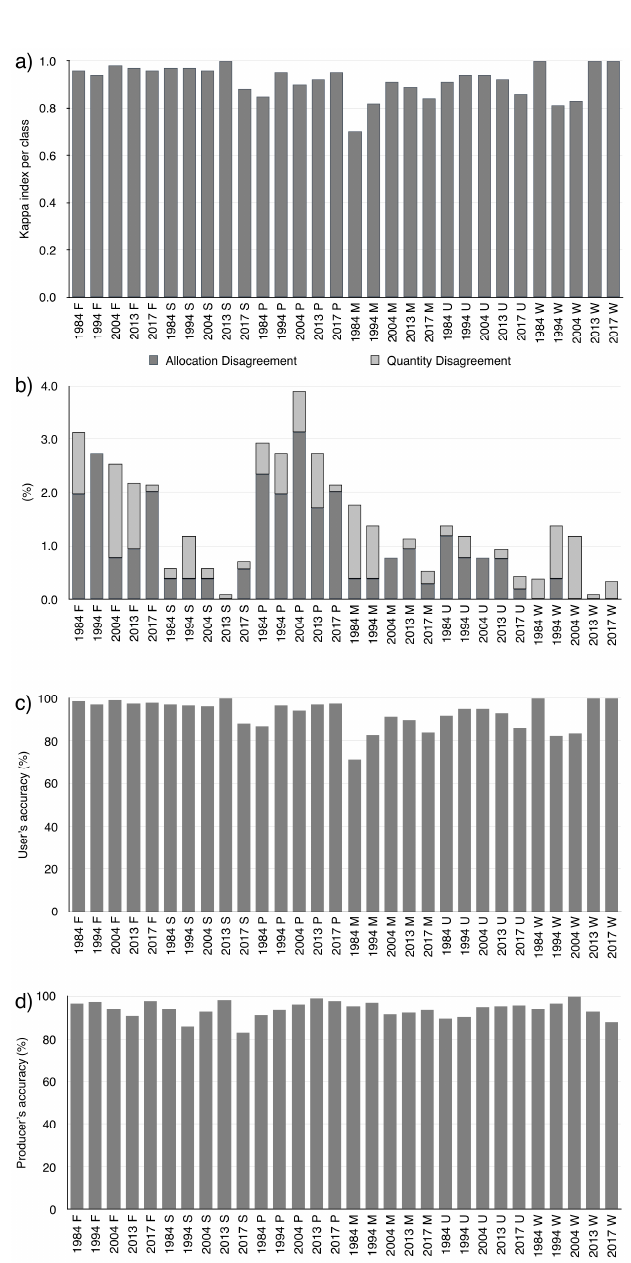
Figure 5. Kappa index ( a ), allocation and quantity disagreements ( b ), user ( c ) and producer’s ( d ) accuracy per class for 1984, 1994, 2004, 2013 and 2017mosaic images in the IRW.